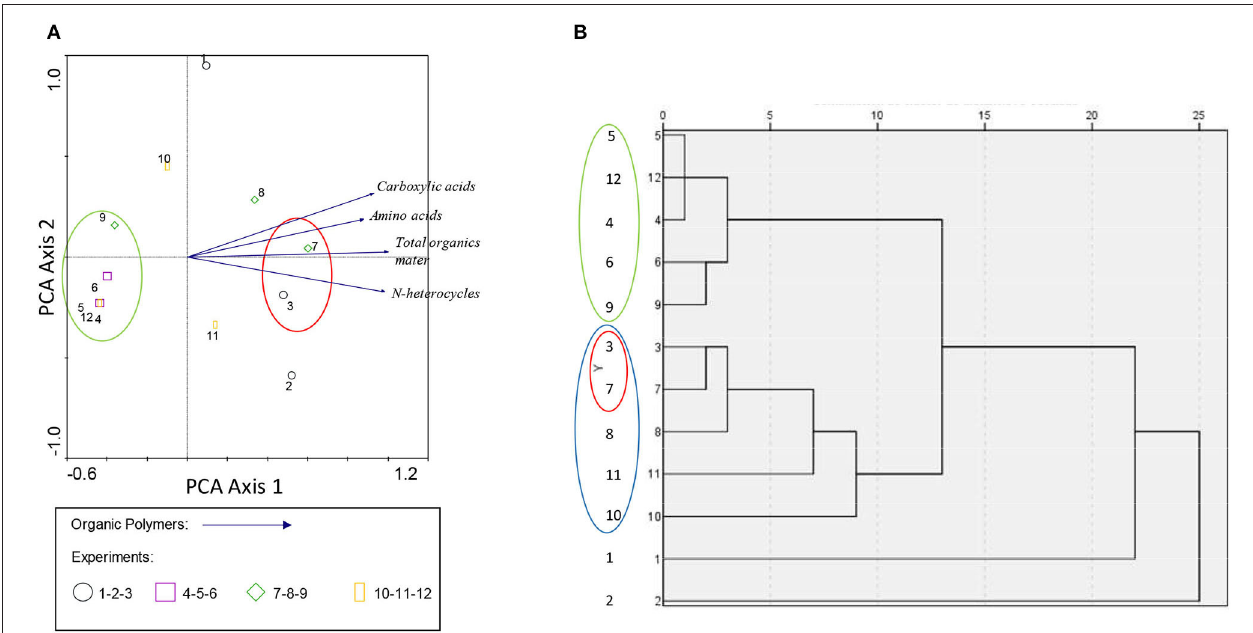
FIGURE 5 | Soluble polymers statistical analysis. (A) PCA plot based on the relative proportions of amino acids, carboxylic acids, N-heterocycles, and total organic obtained in every experiment for the soluble polymers. The relative proportions of the different compounds are indicated by arrows. The observed clusters are indicated by circles. (B) Hierarchical dendrograms calculated using PCA components. Experiments are represented by their numbers. The obtained clusters are designated by circles.